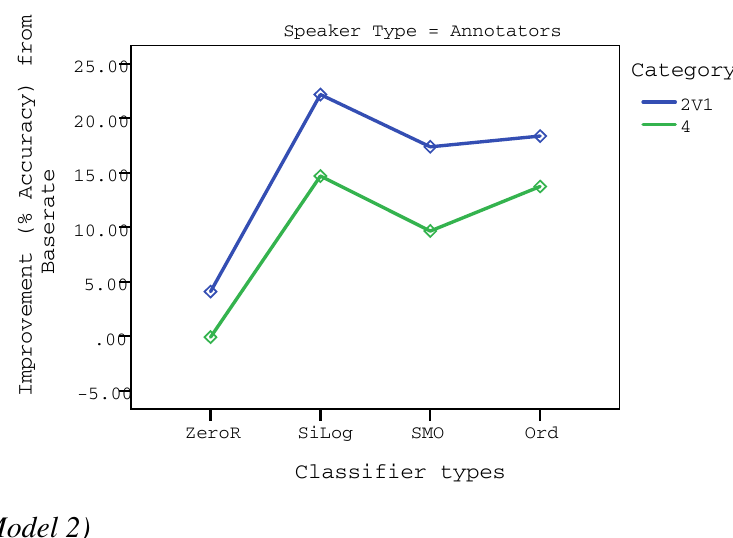
SiLog = Functions.SimpleLogistics, SMO = Functions.SMO, Ord = Meta.Ordinal. U = user data, A = annotator data. Results were truncated to display only the best statistically significant classification improvements (at p < 0.05). Figure 2. Summarized interaction chart for the annotators’